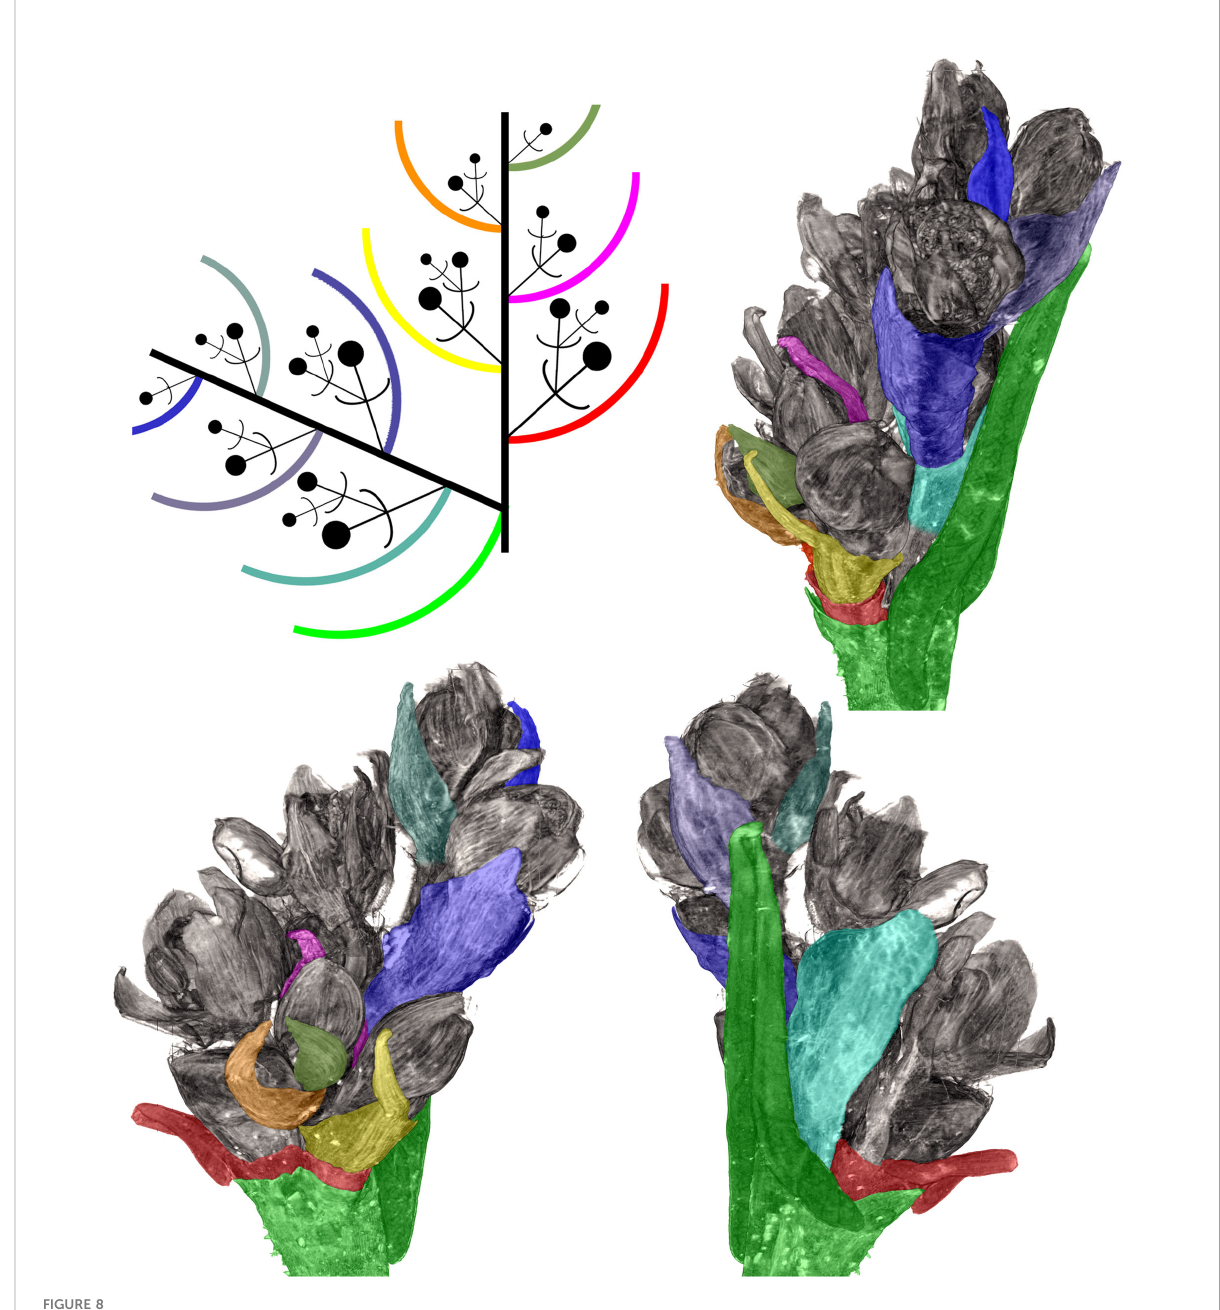
FIGURE 8 Distal part of fl owering unit in a herbarium specimen of a ruderal plant of Fagopyrum tataricum from Middle Russia (MW0325480). Different views of a 3D image produced using X-ray microtomography and manually coloured to show different organs. A diagram in the upper left corner can be used as key to colours. The uppermost lateral thyrse and terminal thyrse are